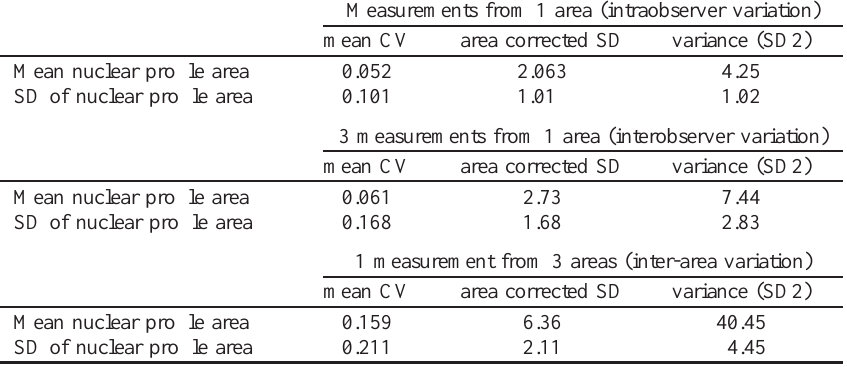
Table 6 Variation of nuclear morphometric measurements by one observer in one measurement area, by one observer in three different measurement areas (selected by three pathologists), and by three measurements from the same area. This experiment was done to estimate the influence of field selection on the measurement results. 40 µ m 2 has been used to represent the theoretical average nuclear area, and 10 µ m 2 to represent the SD of nuclear area of